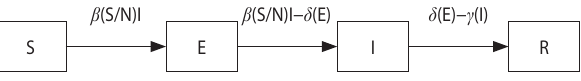
Figure 1. The susceptible-ex posed-infected-recovered (SEIR)